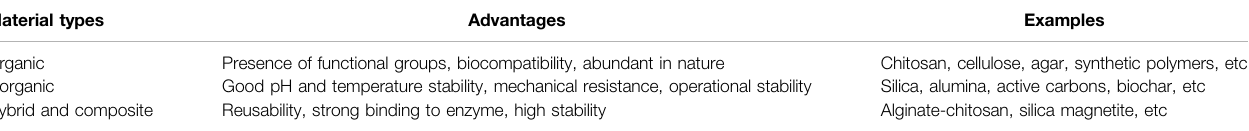
TABLE 3 | Categories and properties of support materials for